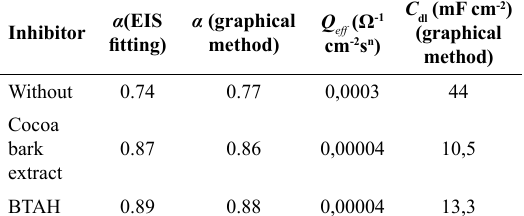
Figure 6. Imaginary part of the impedance as a function of frequency for CS - ASTM 1020 after immersion for 90 min in 18.23 g L -1 HCl solution in the presence of 1.112 g L -1 cocoa bark extract. Table 3. Values of the graphical and fit methods for the EIS data for CS – ASTM 1020 in 18.23 g L -1 HCl solution in the absence and in the presence of 1.112 g L -1 of inhibitor. C calculated with Eq. (6) dl with α from the graphical determination method.